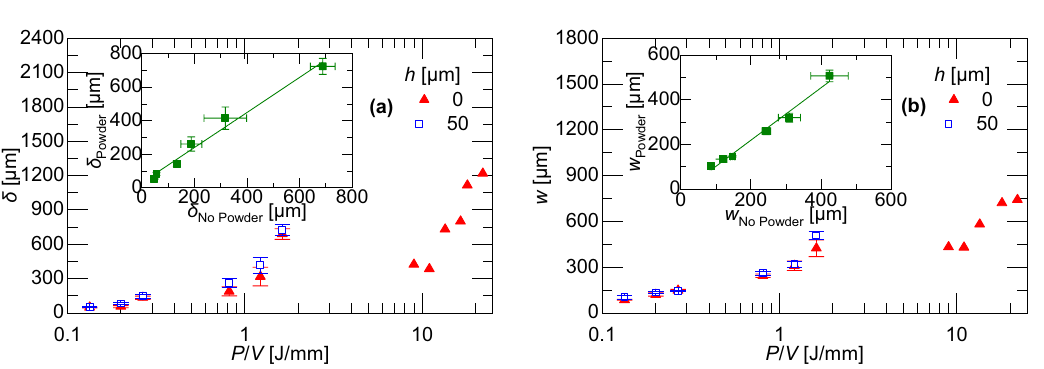
Figure 9. Melt pool (a) depth and (b) width as function of linear energy density for experiments with powder and no powder. Insets show melt pool dimensions for experiments with powder versus experiments without